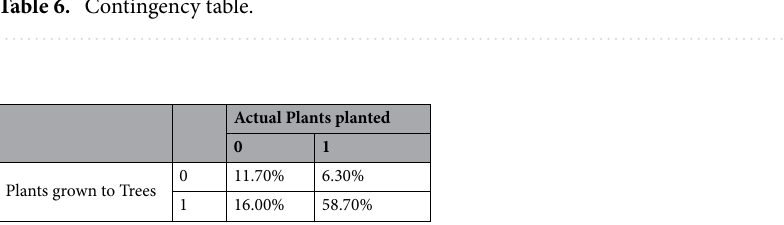
Table 6. Contingency table.